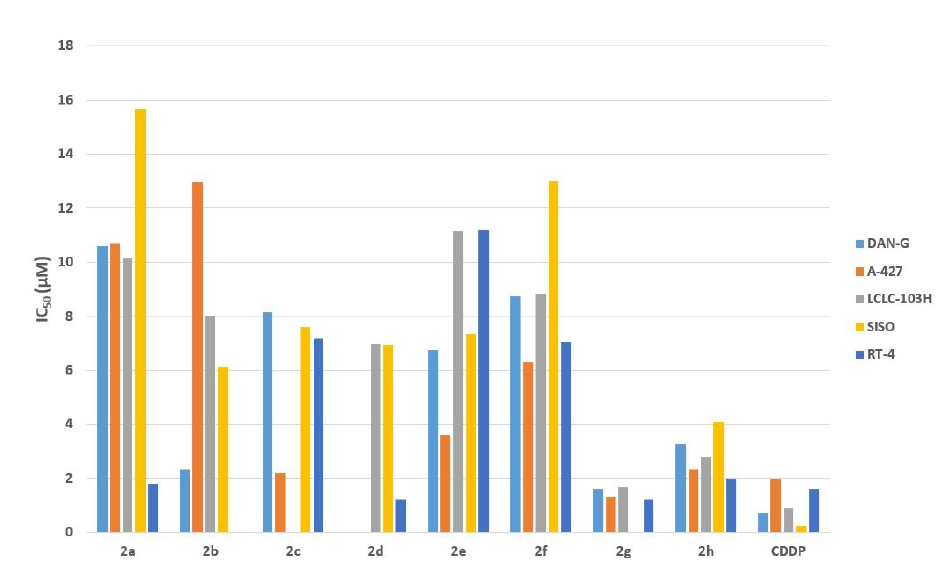
Figure 10. IC 50 ( μ M) values of copper(II) complexes of 2-imino-2 H -chromen-3-yl-1,3,5-triazines 2a - h on five human tumor cell lines (DAN-G, A-427, LCLC-103H, SISO, RT-4) compared to cisplatin (CDDP).